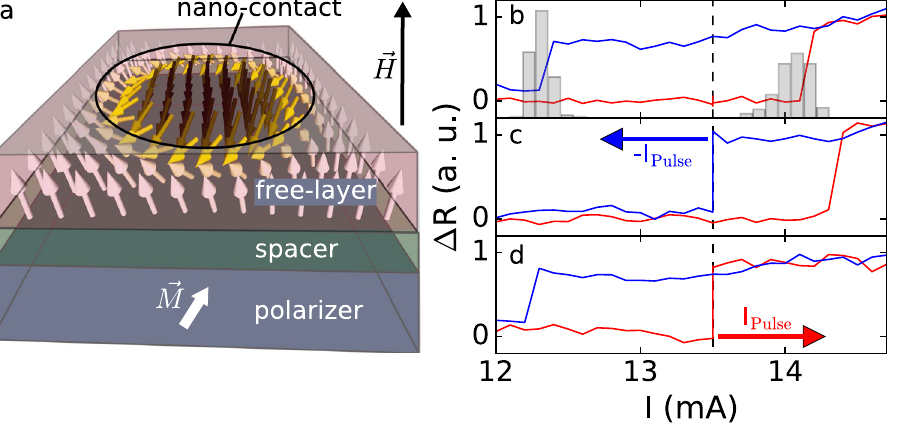
Figure 1. ( a ) Schematic of a multilayer with a magnetic droplet. Electrons are injected through a nanocontact to the free layer and move from the free layer (red) to the polarizer (blue) for positive current polarity. An external field is applied perpendicularly to the film plane, partly canting the polarizer magnetization. ( b ) Resistance vs. current at a fixed field of 0.7 T after subtracting a background caused by Joule heating. The overlaid histogram indicates the distribution of generation and annihilation currents. ( c ) The nanocontact is biased at 13.5 mA in the higher resistance state (dashed line). A negative current pulse annihilates the droplet, as seen by the step decrease in nanocontact resistance. ( d ) Starting in the non-droplet state a positive current pulse can generate the droplet, as seen by the step increase in nanocontact